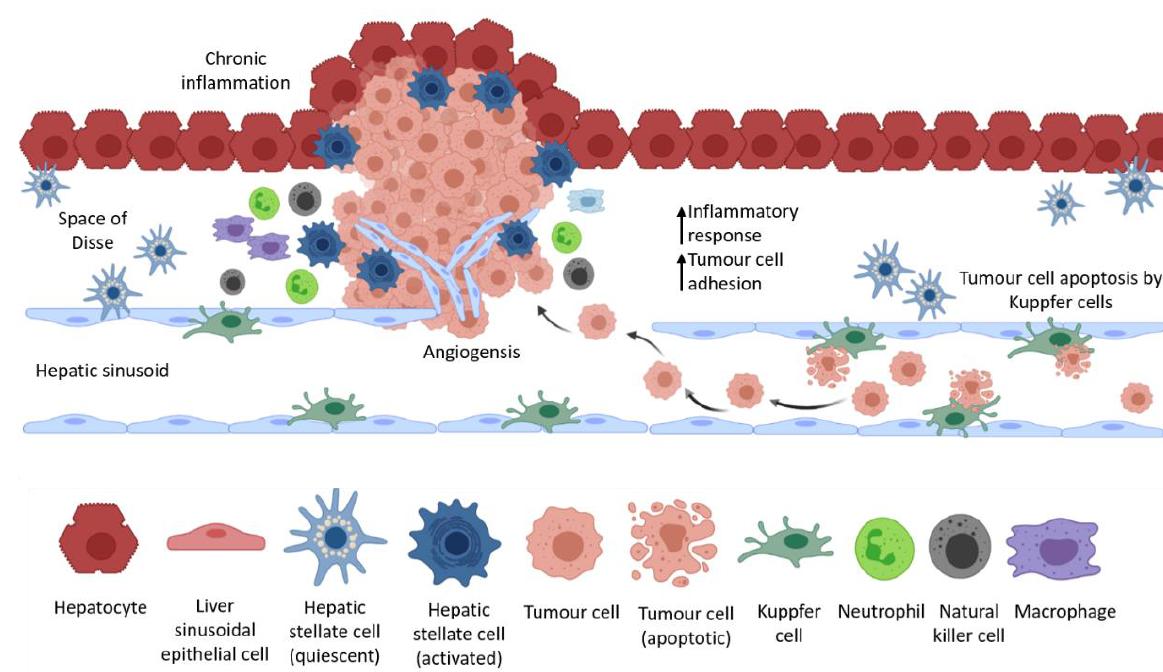
Figure 2. Interactions between liver resident cells and tumour-derived cells in the liver. Circulating tumour cells that become lodged in the hepatic sinusoids evade anti-tumour mechanisms of liver resident cells, form blood vessels that resemble the hepatic sinusoids, and grow as metastatic lesions in the liver.